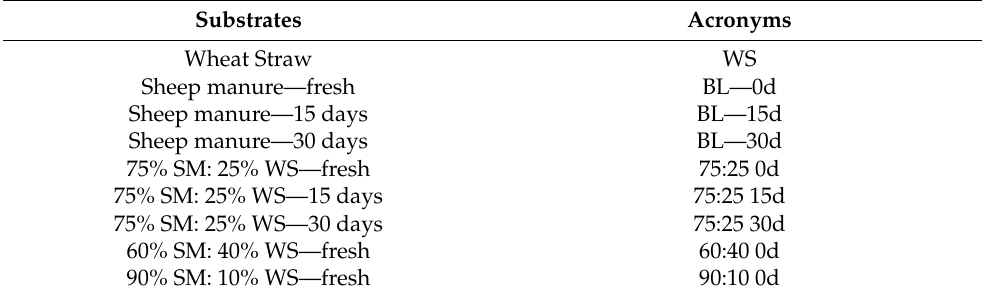
Table 3. Substrates for biogas potential and their attributed